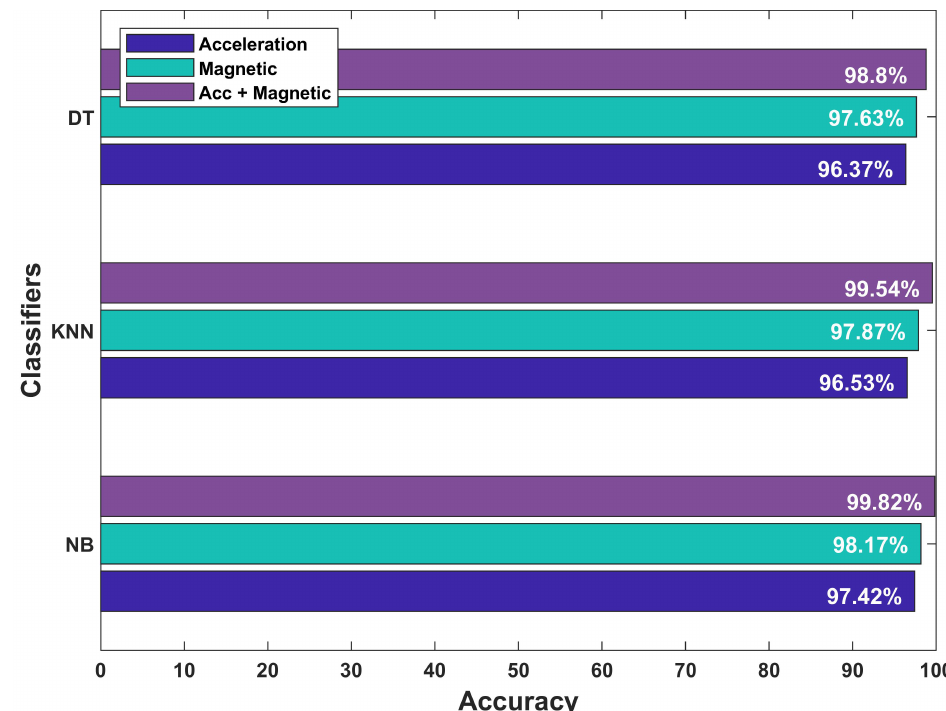
Figure 15. Results for phone orientation